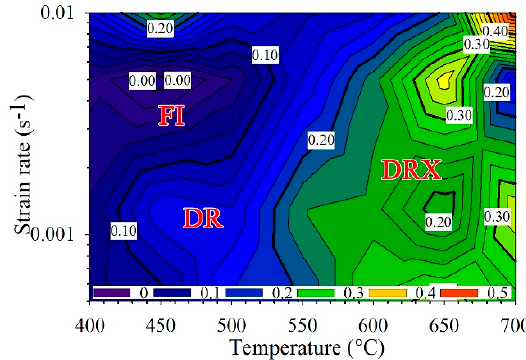
Figure 9. Processing map for warm deformation of the as-quenched Fe-0.36wt.%C-1wt.%Cr steel at ε = 0.35. Notation: FI—flow instability; DR—dynamic recovery; DRX—dynamic recrystallization.